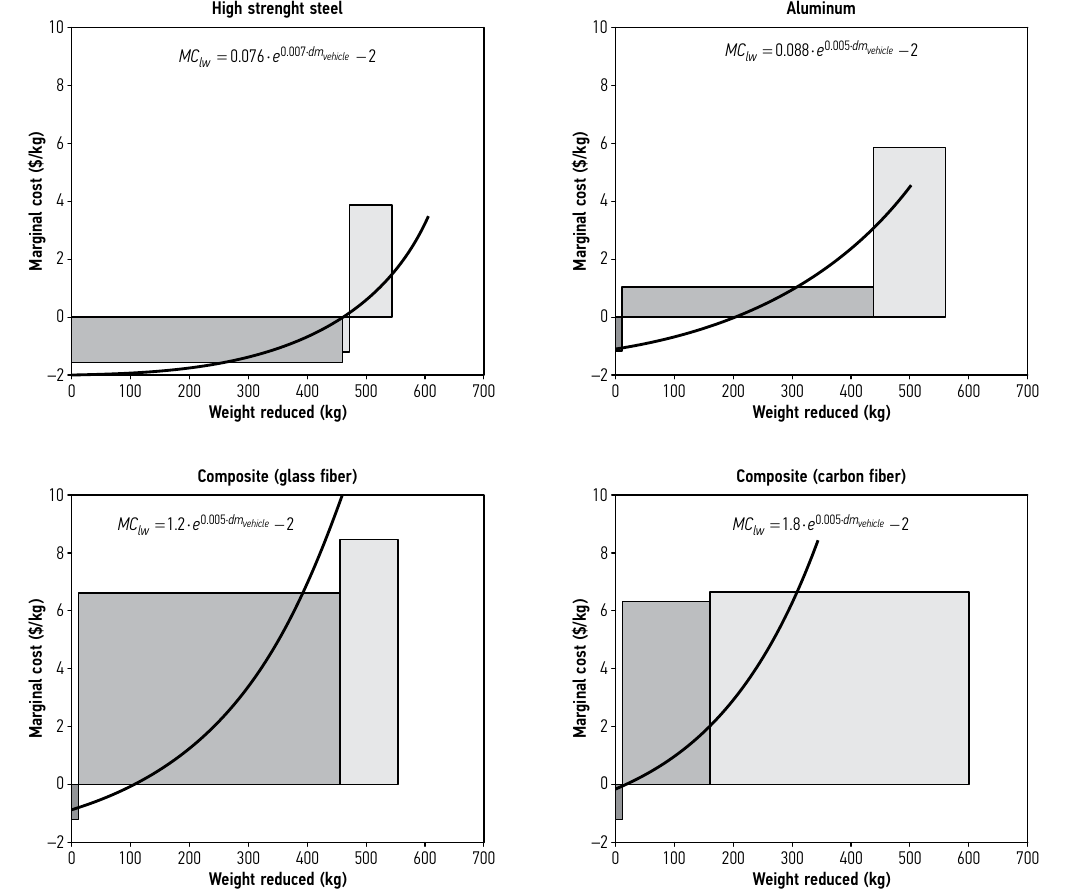
Fig. 6. Marginal cost of reducing vehicle weight for four scenarios based on different materials applied to three vehicle subsystems